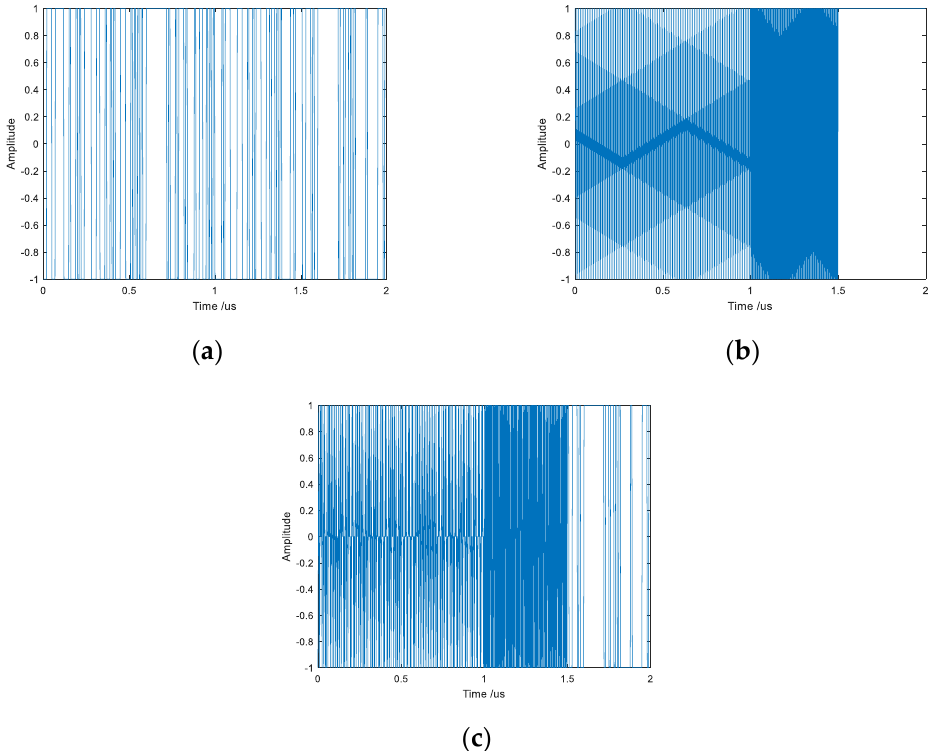
Figure 3. PSK, FSK, and Hybrid FSK-PSK signals. ( a ) PSK signal. ( b ) FSK signal. ( c ) FSK-PSK signal.